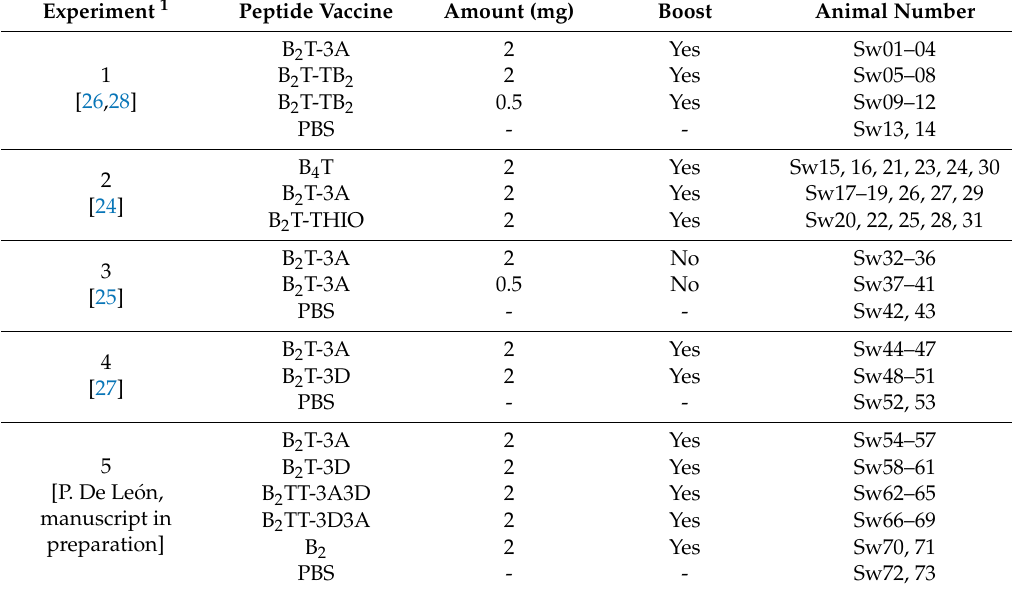
Table 2. Pigs immunized with dendrimer peptides analyzed in this